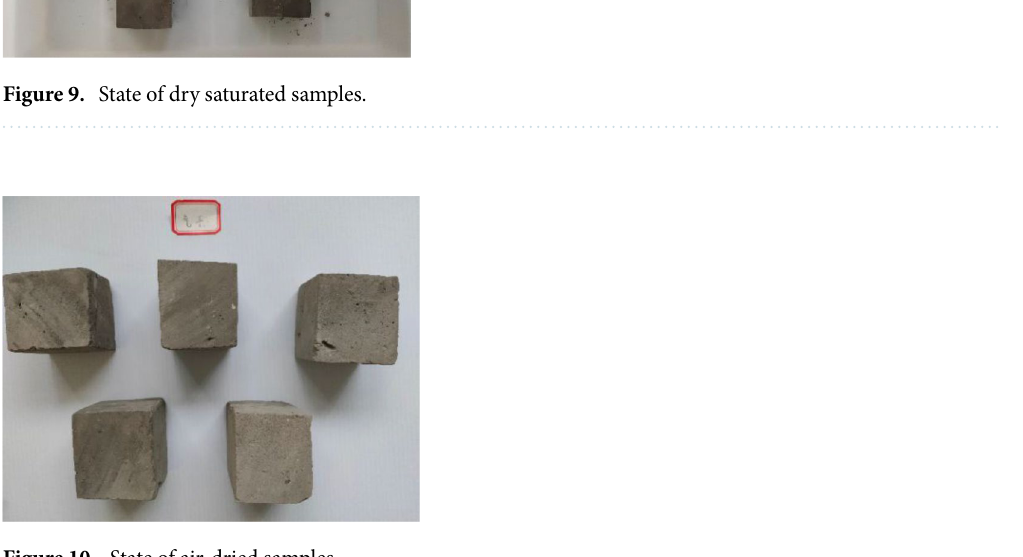
Figure 10. State of air-dried